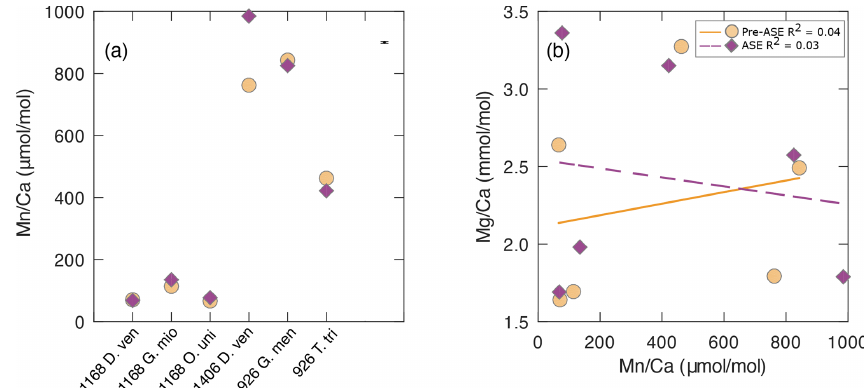
Figure 5. (a) Mn / Ca results for the pre-ASE (yellow circles) and ASE-treated (purple diamonds) foraminifera. (b) There is no discernible relationship between Mn / Ca and Mg / Ca, indicating that despite high Mn / Ca values indicative of secondary authigenic signals, foraminiferal Mg / Ca is not affected. Solid yellow line: pre-ASE linear fit; dashed purple line: ASE linear